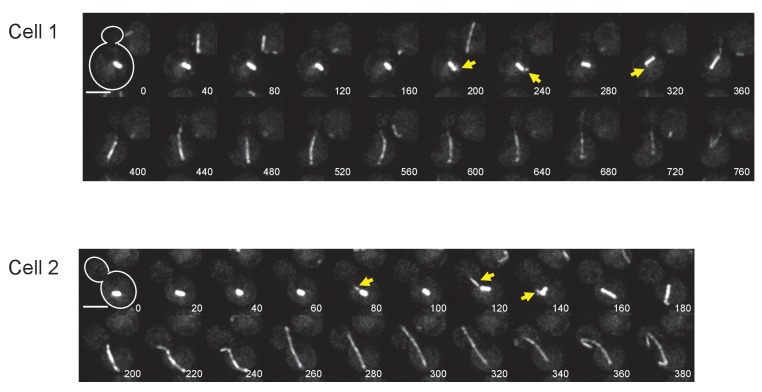
Time-lapse microscopy of GFP-TUB1 cells.Representative images of time-lapse microscopy of GFP-TUB1 cells (HPH194). Cells were grown in SD complete medium at 30°C. Consecutive sections were taken every 40 s for Cell1 and 20 s for Cell2. Yellow arrows point cMTs in pre-anaphase stages. Scale bar, 2 µm.